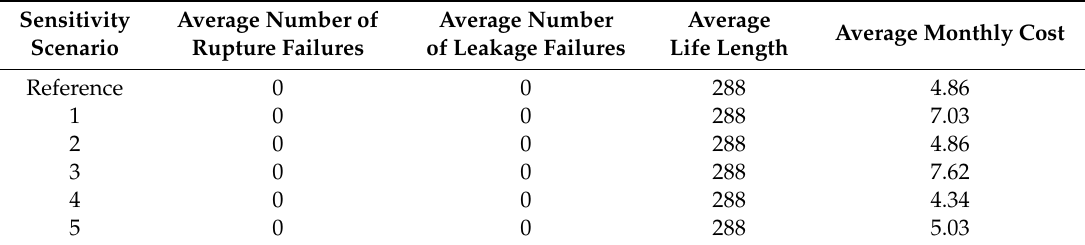
Table 10. Performance summary for the sensitivity analysis scenarios in comparison with the reference sensitivity scenario in 20